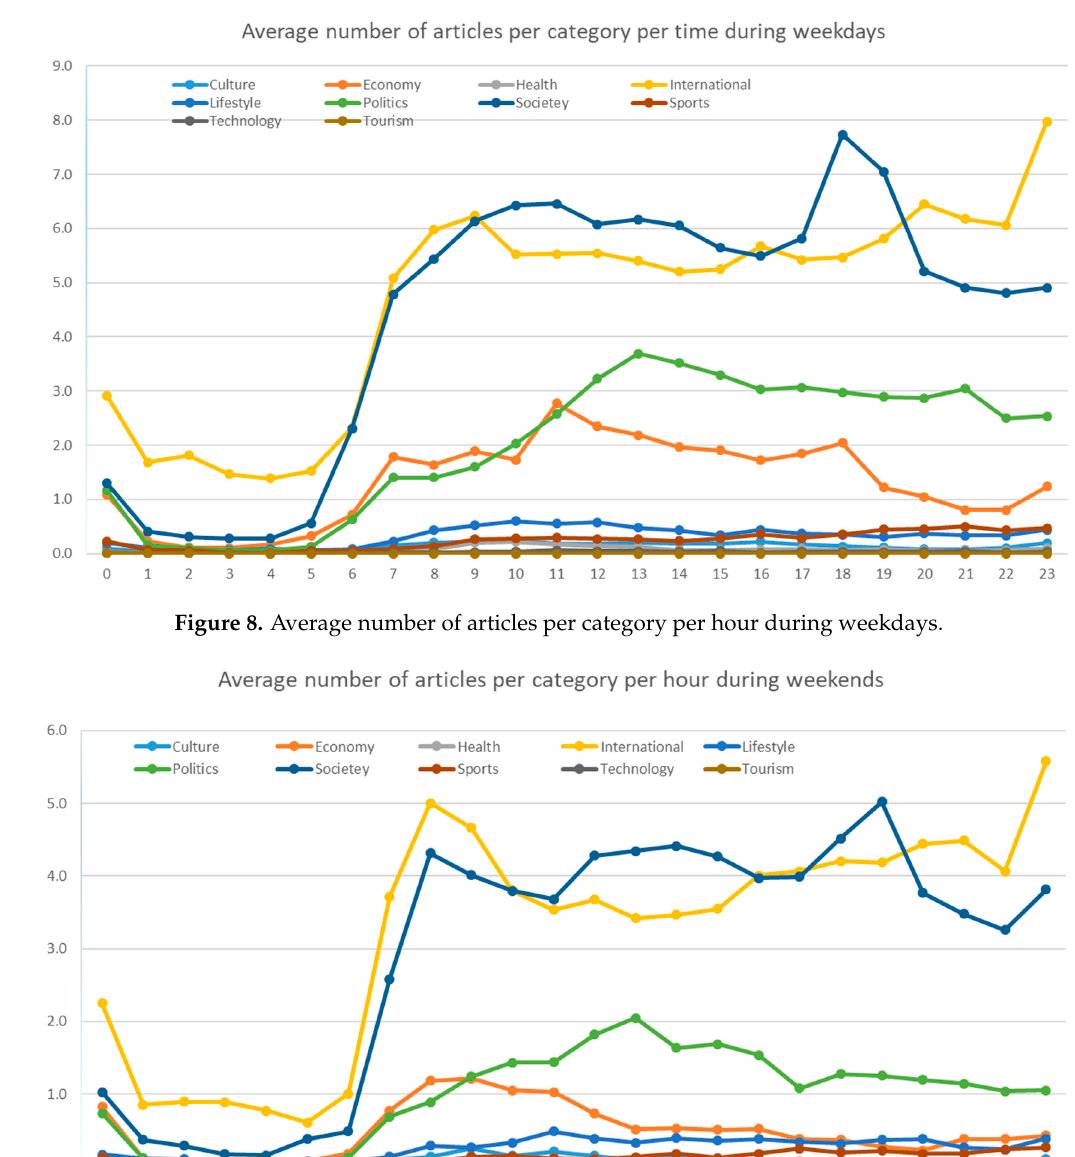
Figure 9. Average number of articles per category per hour during